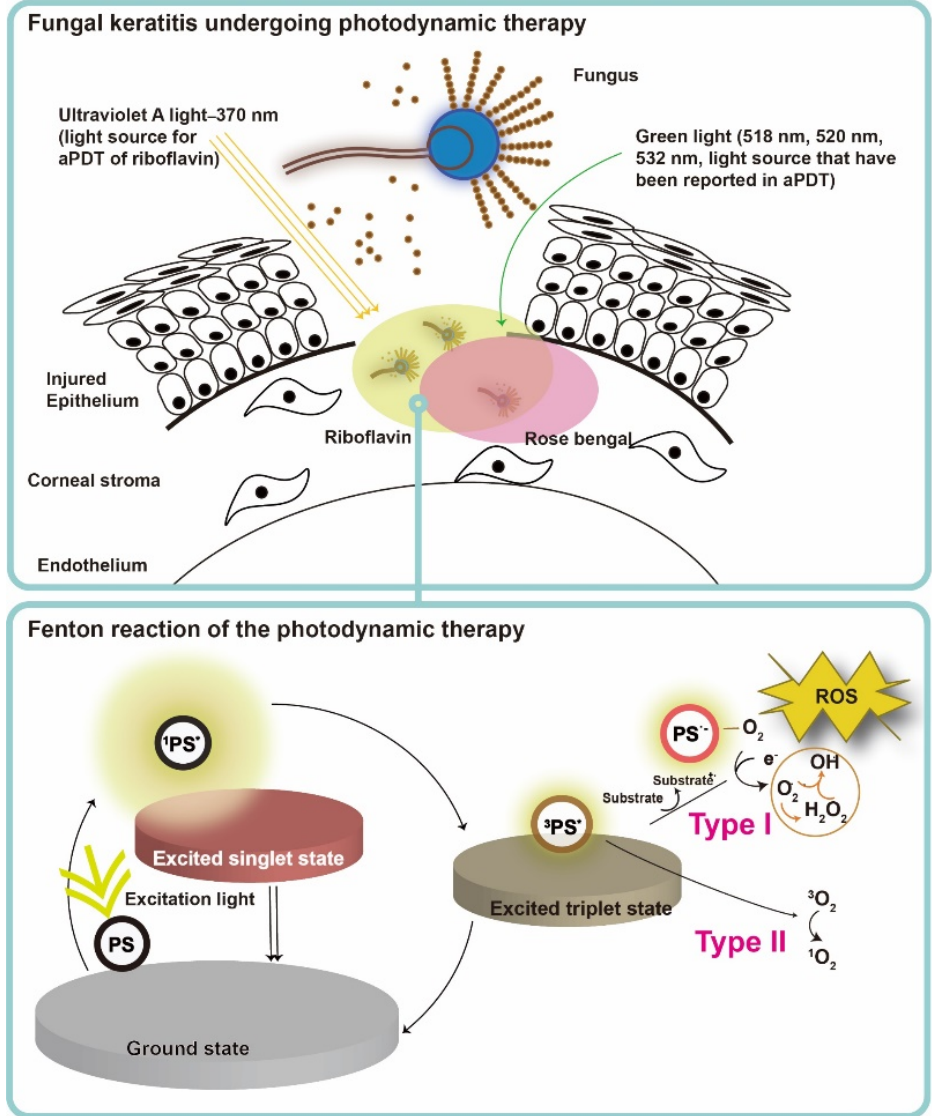
Figure 3. Schematic illustration of antimicrobial photodynamic therapy mechanism for fungal keratitis. The ground-state photosensitizer (PS) absorbs photons and is excited to the first short-lived excited singlet state and either returns to the ground state or undergoes intersystem crossing to a long-lived triplet state. The triplet state PS exerts downstream function via a type I or type II photosensitization process. For type I reaction, charge is transferred from the excited PS to oxygen (O 2 ), and therefore leading to the formation of hydrogen peroxide (H 2 O 2 ), hydroxyl radical (HO·), and superoxide anion (O 2 − ·). For type II reaction, the triplet PS undergoes energy exchange with triplet ground state oxygen, leading to the formation of singlet oxygen 1 O 2 . Type I and type II reactions can occur at the same time during irradiation. Nevertheless, type II reaction is mainly involved in antimicrobial photodynamic action. The reaction depends most importantly on PS used and the concentration of O 2 in aPDT.